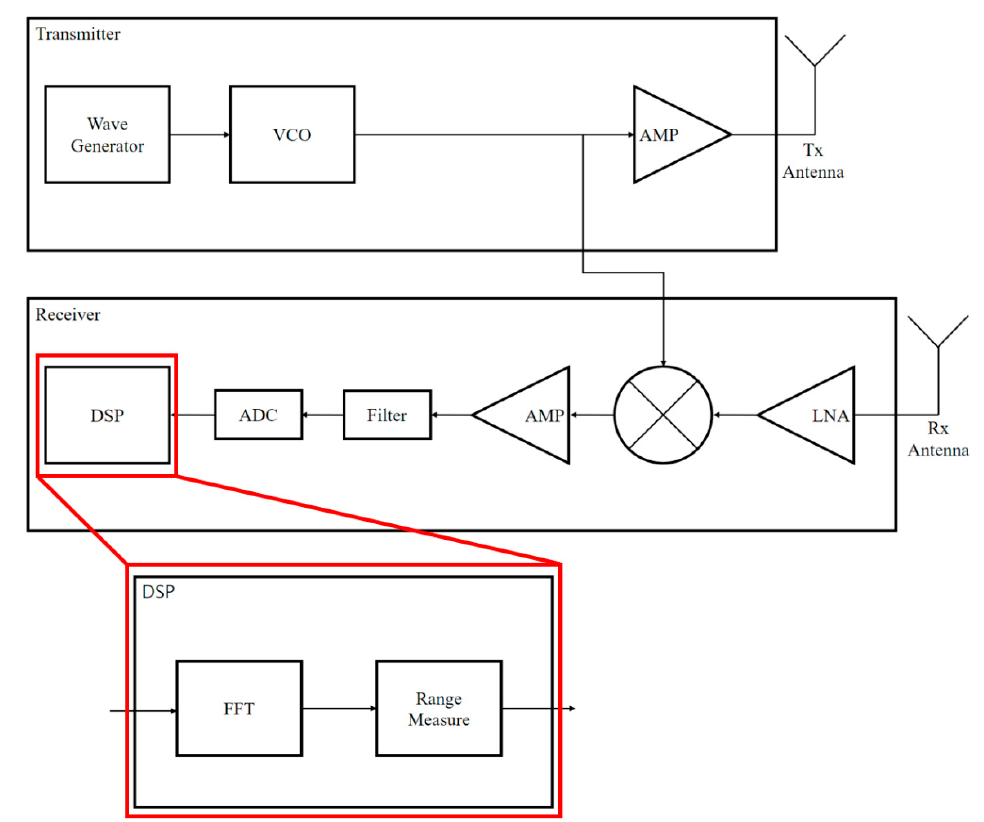
Figure 2. FMCW RADAR Structure.